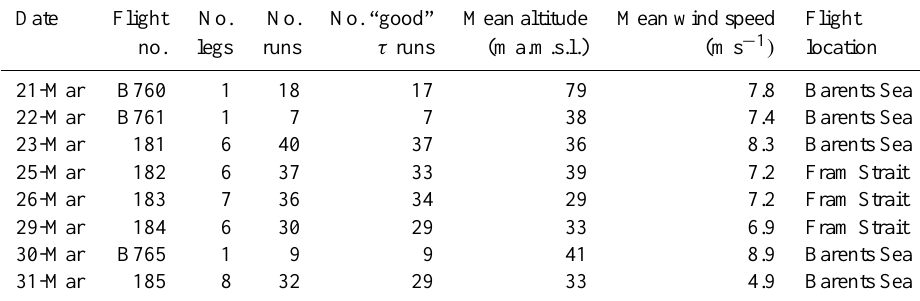
Table 2. Summary of flights during the March 2013 ACCACIA field campaign. Flight numbers preceded by the letter “B” use the FAAM BAE146; the other flights use the MASIN Twin Otter.